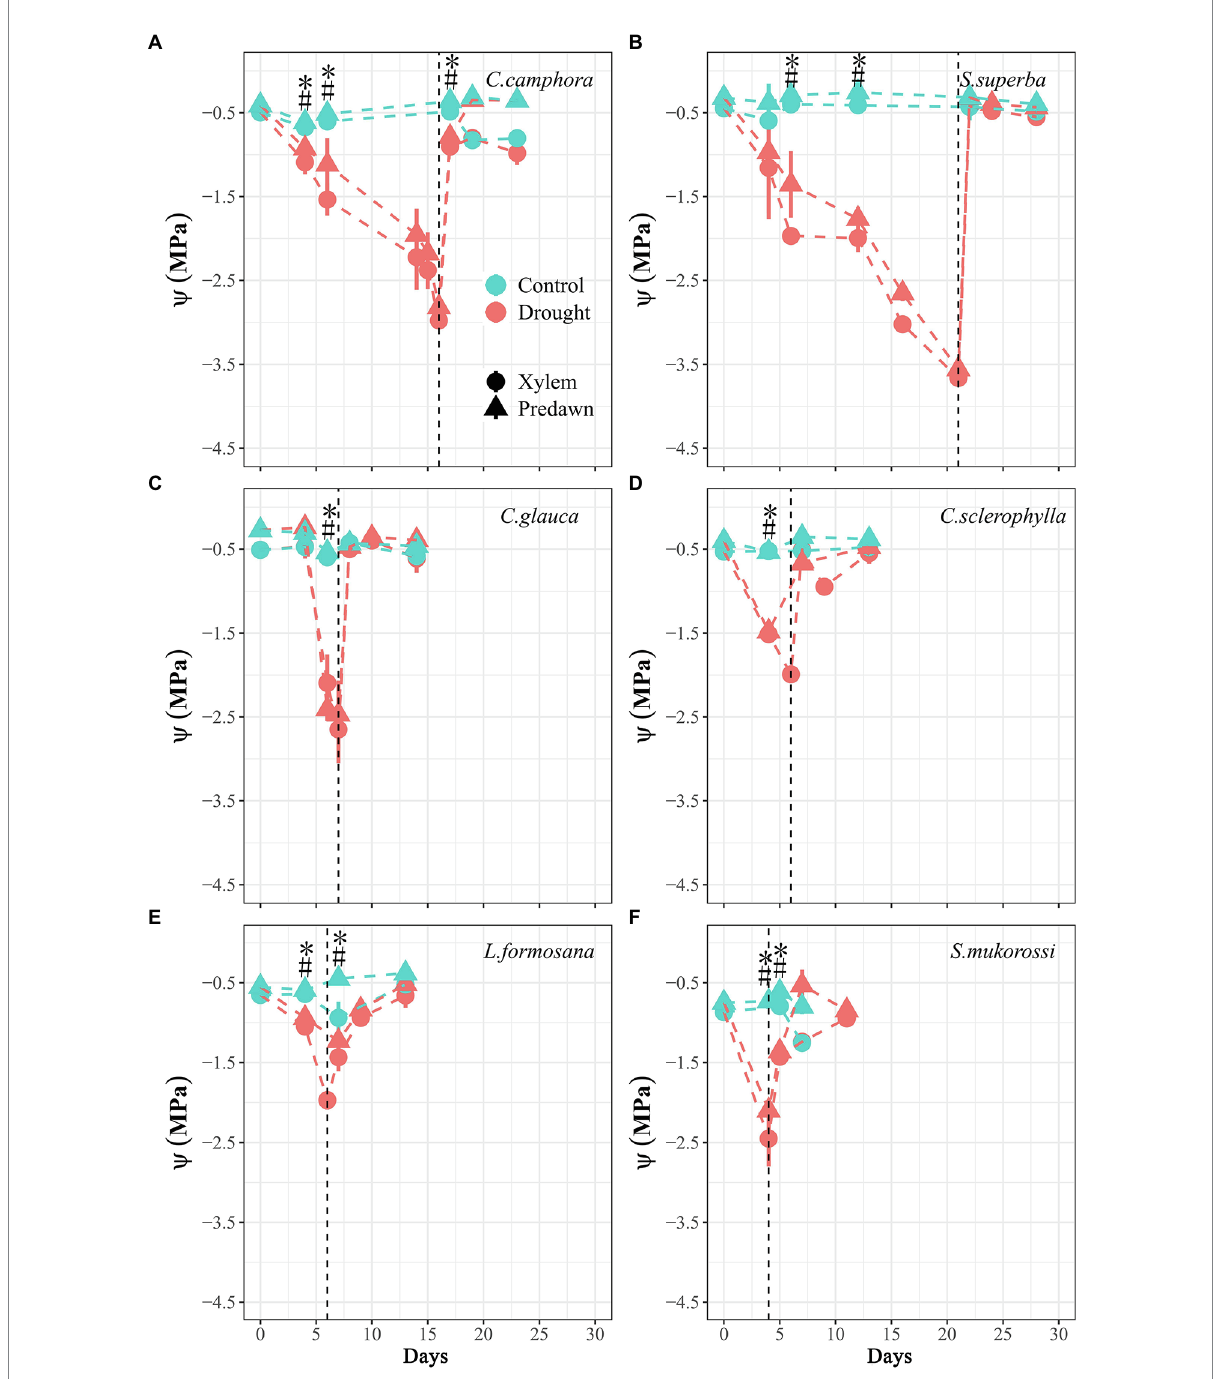
FIGURE 1 Time course of xylem water potential ( Ψ xylem ) and predawn water potential ( Ψ pd ) for seedlings of the six tree species throughout the experimental period. Values are Means ± SE ( n = 3–5). “ * ” or “#” means significant difference ( p ≤ 0.05) for Ψ xylem or Ψ pd between Control and Drought treatments at each sampling date. Control-Well-watered control; Drought-drought and recovery treatment. The vertical lines represent the time for re- watering. The first four species are evergreen species, while the last two species are deciduous